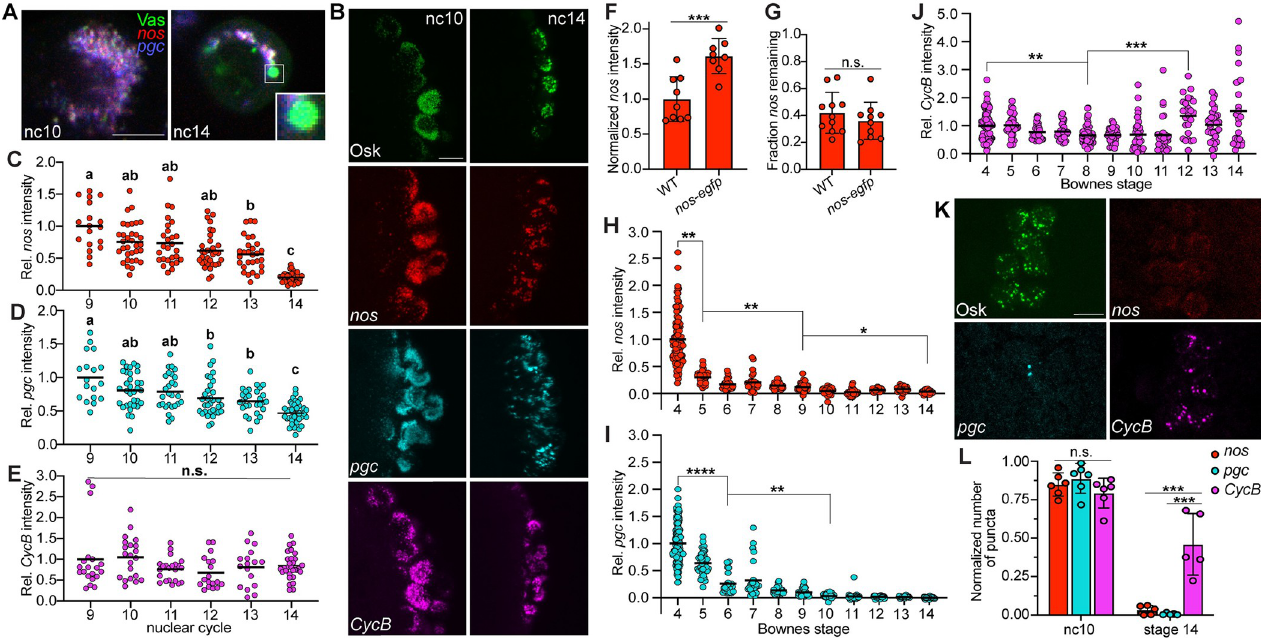
Fig 3. CycB mRNA is protected while nos and pgc mRNAs are degraded. (A) Single confocal sections of a single representative pole cell at nc10 and nc14. nos (red) and pgc (blue) were detected by smFISH. Detection of direct fluorescence of Vas-EGFP (green) was used to mark germ granules. Enlargement shows an individual granule containing Vas protein without any nos or pgc at nc14. (B) Maximum intensity confocal z-projections of representative pole cells in nc10 and nc14 embryos. nos (red), pgc (cyan), and CycB (magenta) mRNAs were detected by smFISH. Anti-GFP immunofluorescence (Osk-sfGFP) or direct fluorescence of Vas-EGFP was used to mark germ granules (green) and detect protein levels. (C–E) Quantification of the fluorescence intensities of nos (C), pgc (D), and CycB (E) per pole cell relative to the fluorescence intensity of Osk or Vas at each nuclear cycle after pole cell budding begins. Values were normalized to nc9, n = 4–9 embryos per nc. Nuclear cycles that do not share a letter are significantly different as determined by Kruskal–Wallis one-way ANOVA with Dunn’s post hoc test ( p < 0.05). (F, G) Quantification of total nos intensity in the germ plasm in wild-type and nos-egfp embryos at nc10-11 (F) and nc14 (G). Values were normalized to the wild type (F) and to nc10-11 values from the same genotype (G), respectively, n = 8–11 embryos per genotype. nos levels were compared by Student’s t test. (H–J) Quantification of the fluorescence intensities of nos (H), pgc (I), and CycB (J) per pole cell relative to the fluorescence intensity of Osk or Vas at each Bownes stage from pole cell formation to the end of pole cell migration. Values were normalized to stage 4, n = 4–24 embryos per stage. mRNA levels were compared by Kruskal–Wallis one-way ANOVA and Dunn’s multiple comparison test. (K) Maximum intensity confocal z- projections of representative pole cells in stage 14 embryos. Osk (green), nos (red), pgc (cyan), and CycB (magenta) were detected as in (B). (L) Quantification of the number of nos , pgc , and CycB puncta relative to the number of germ granules in nc10 and stage 14 embryos, n = 5–6 embryos per stage. One-way ANOVA with Tukey–Kramer post hoc tests were performed at each time point to compare the 3 mRNAs. Individual data points and mean (C–E, H–J) or mean ± SD (F, G, L) are shown. * p < 0.05, ** p < 0.01, *** p < 0.001, **** p < 0.0001, and n.s., not significant. Source data for the graphs in Fig 3C–3J and 3L are provided in S1 Data. Scale bars: 10 μ m. smFISH, single-molecule fluorescence in situ